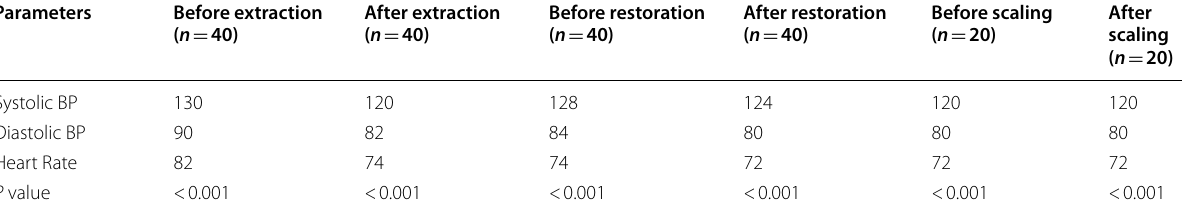
Table 5 Comparative evaluation of parameters of parents before and after treatment procedures Parameters